Question: Summarize what this figure shows in one sentence.
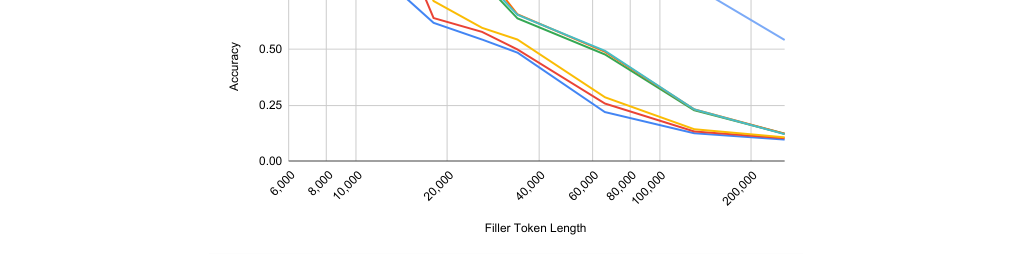
Answer: PassKey Retrieval Accuracy Using BSWA (M1,2,4), Feedback Memory Segments (FM1,2,4), Static Summary Tokens (SUM FAM) and FAM